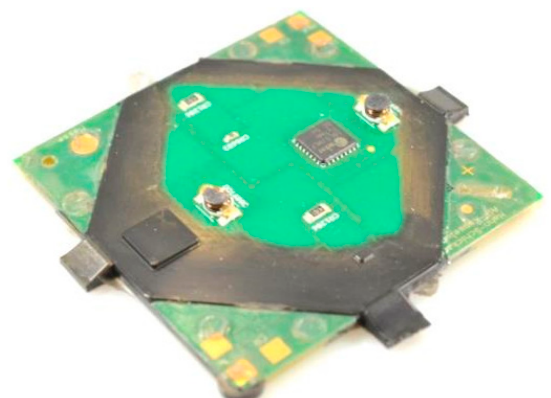
Figure 12. Significant uncovered areas of the package during mold trials MT02 due to the bent PCB.